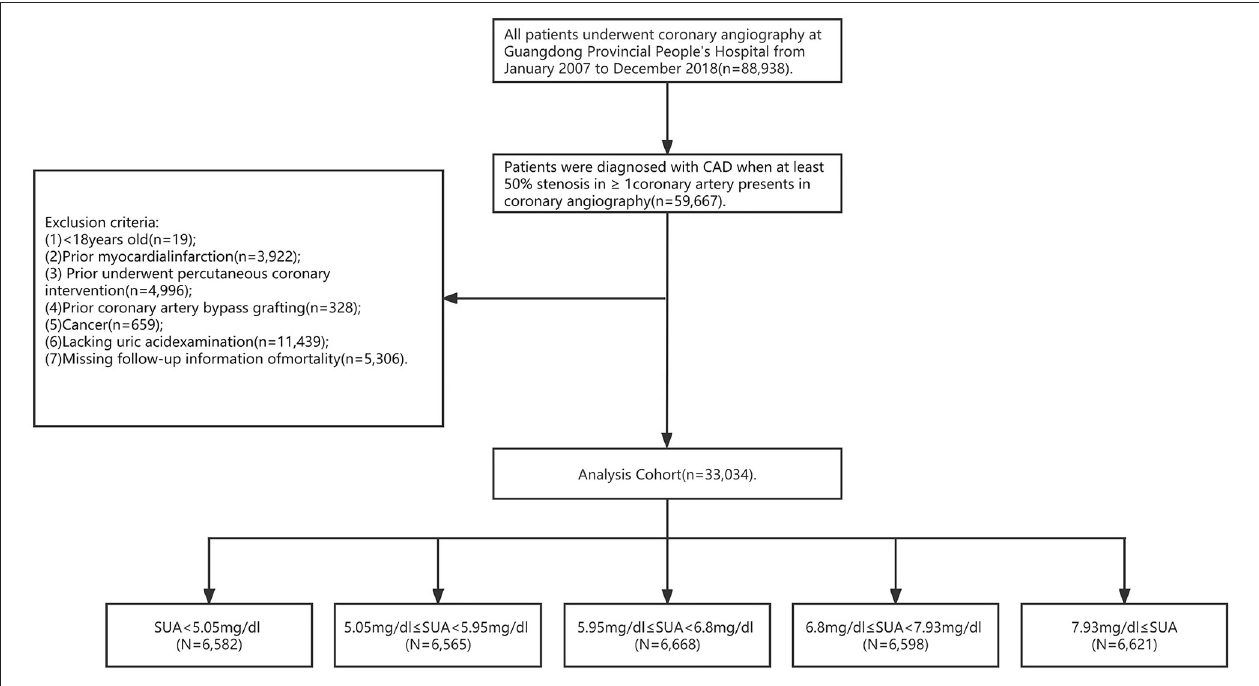
FIGURE 1 | Study flow